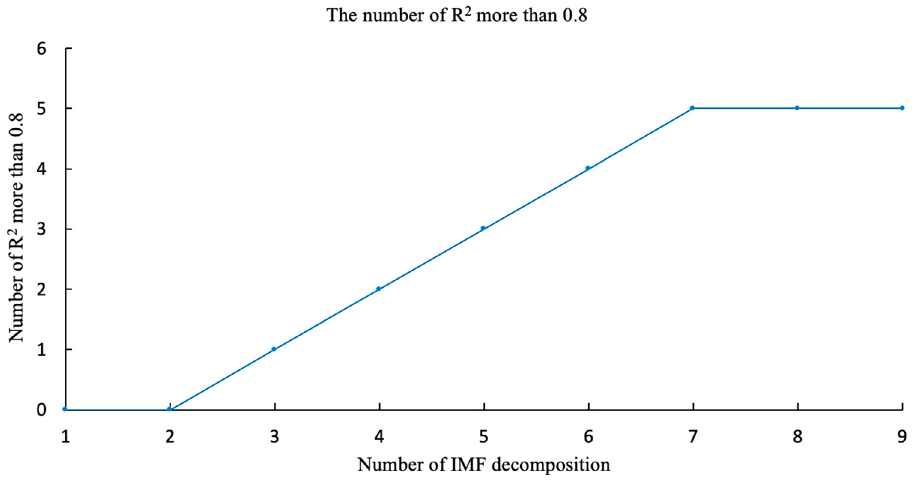
Figure 7. The number of R 2 more than 0.8 vs. number of IMF